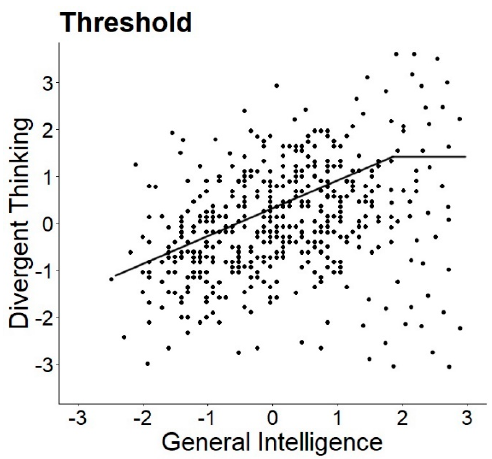
Figure 1. Schematic representations of the relation between creativity and intelligence. The x- and y-axis display z standardized values.